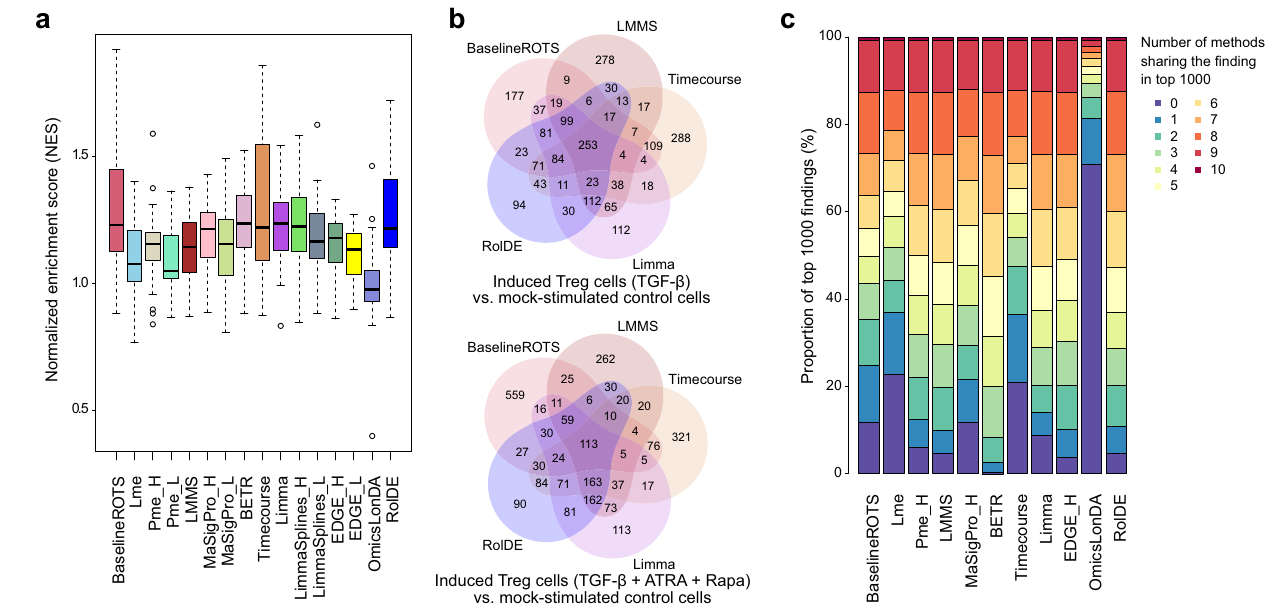
Fig. 4 | Biological relevance and shared fi ndings between the methods in the experimental human-induced T regulatory (iTreg) cell data. a The normalized enrichmentscores(NES)fromthegenesetenrichmentanalysis(GSEA)of17known Treg-related gene sets over comparisons of the two different induction protocols and the mock-stimulated control cells ( n =3 biologically independent samples in eachcomparisongroup,34NESvaluesforeachmethod).Theboxplotsdisplaythe NESscoresforeachmethod,includingmedian(horizontalblackline),interquartile